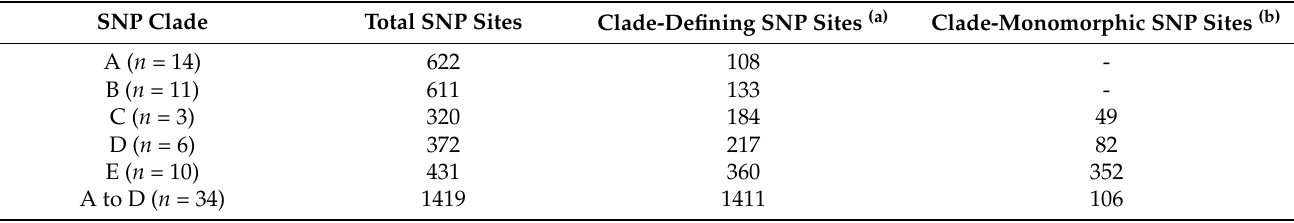
Table 1. Number of M. bovis strains within each SNP clade (A to E) and identification of clade-defining and clade- monomorphic SNP